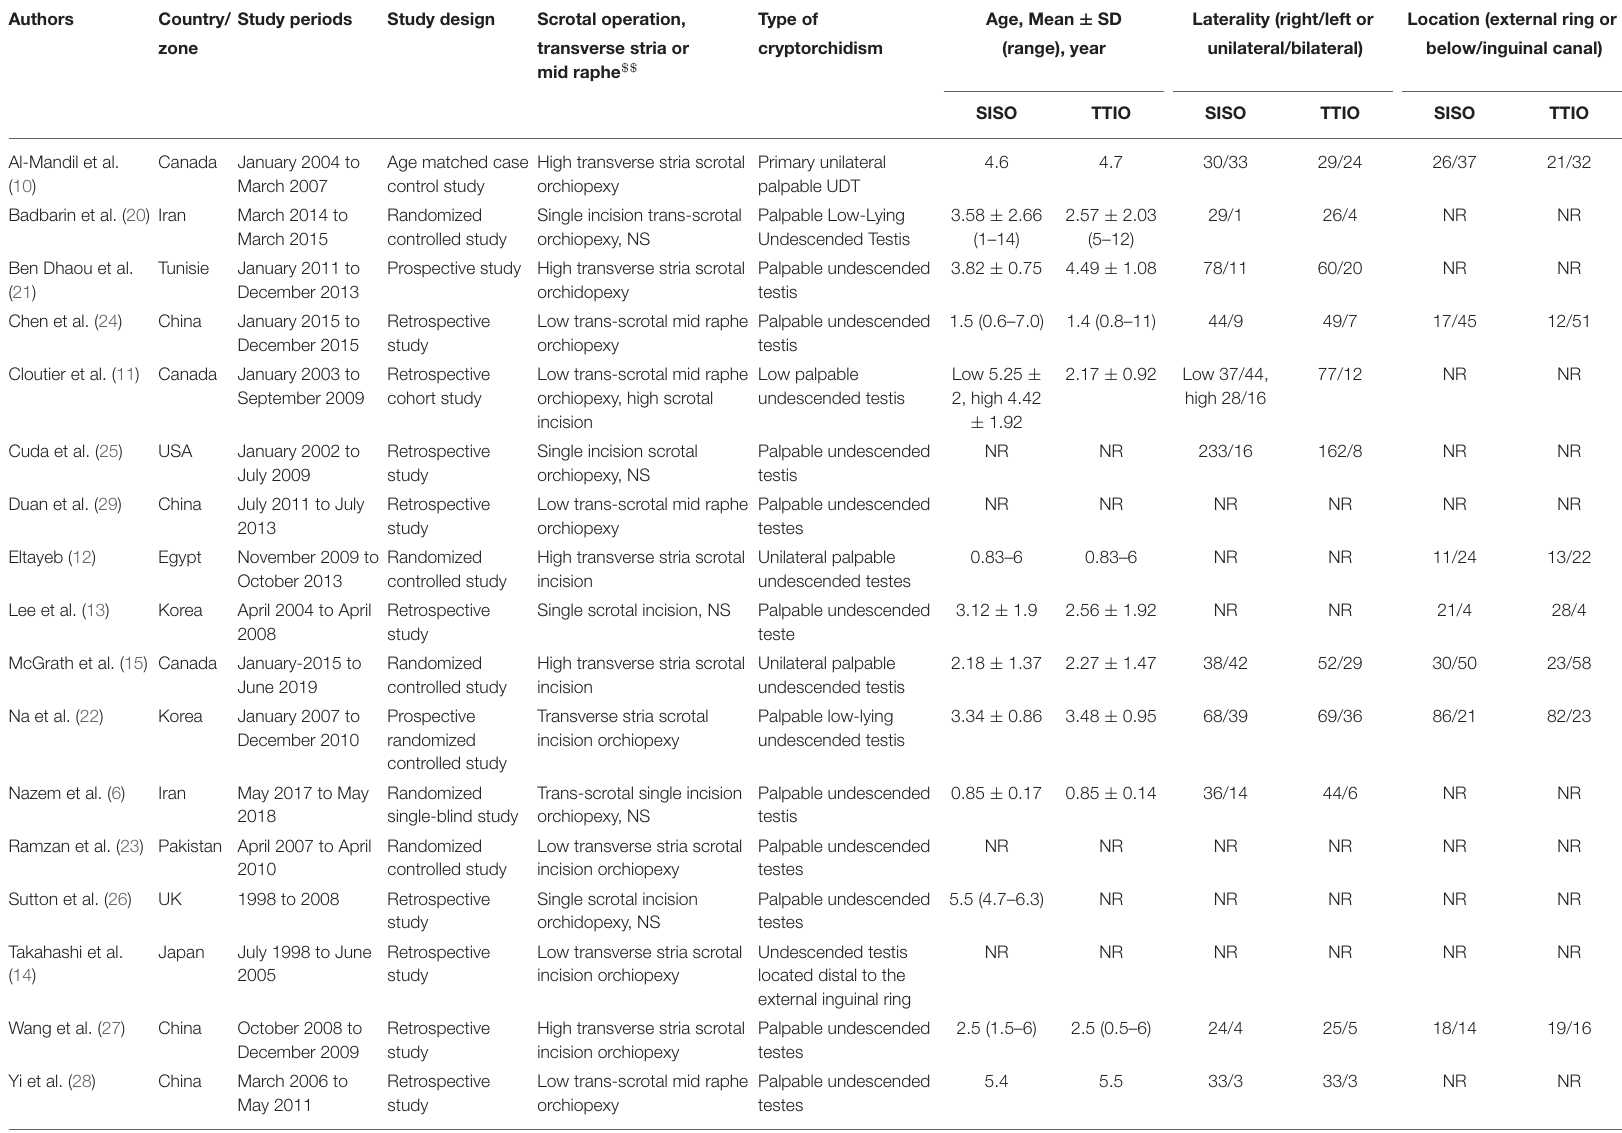
SISO indicates single-incision scrotal orchiopexy; TTIO, traditional two-incision inguinal orchiopexy; NR, not reported; NS, not specified. $$ These two single-incision orchiopexy techniques: high transverse stria scrotal incision and low trans-scrotal mid raphe